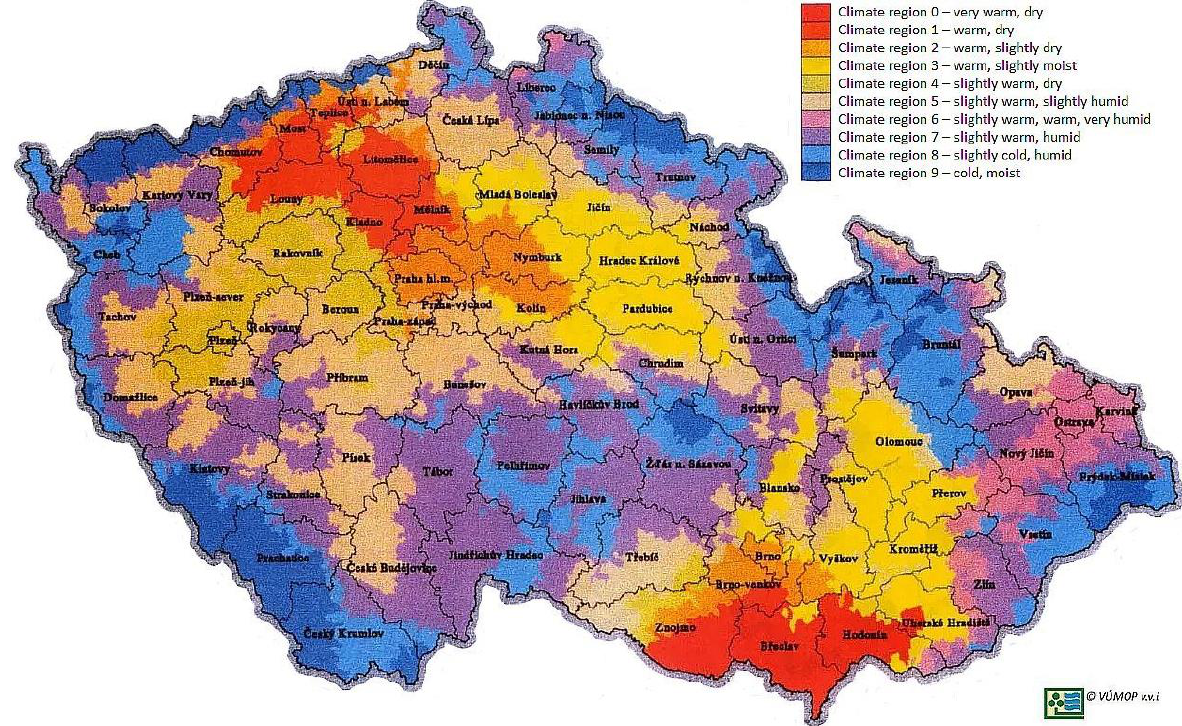
Figure 2. Climate regions in the Czech Republic.